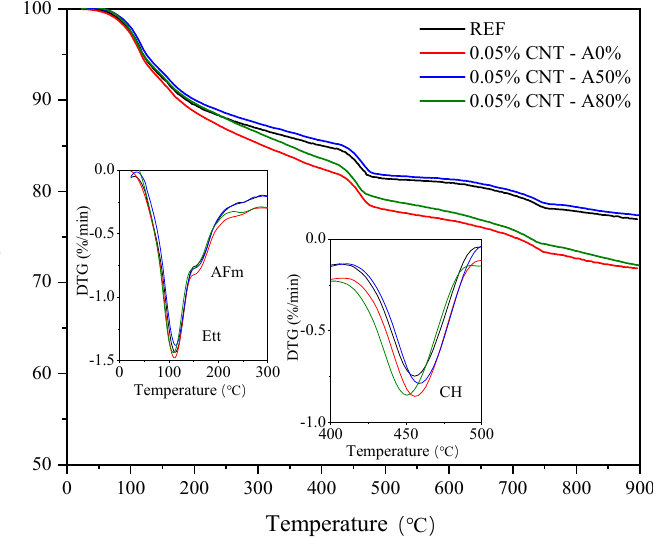
Figure 15. TGA and DTG curves of the pastes at 28 days of hydration. Ett: ettringite; AFm: aluminate phases; CH: calcium hydroxide.